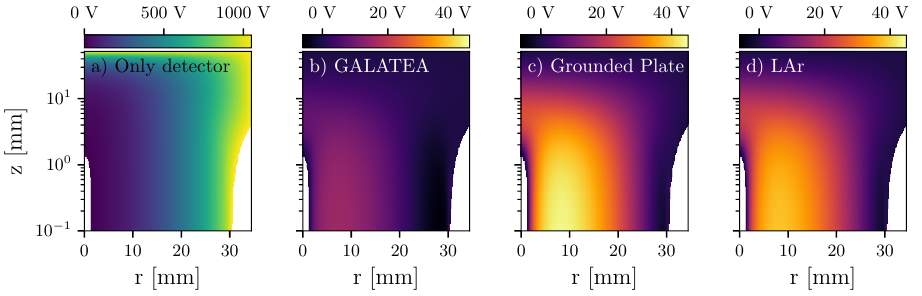
Figure 23. Electric potential of the PPC detector under study as calculated with SolidStateDe- tectors.jl [26]: ( a ) Potential Φ bare as calculated for the bare detector, ( b – d ) changes in the poten- Φ bare for the detector ( b ) mounted in GALATEA, ( c ) GALATEA plus a grounded plate tial Φ env − above the passivated surface at a distance of 2mm, and ( d ) submersed in